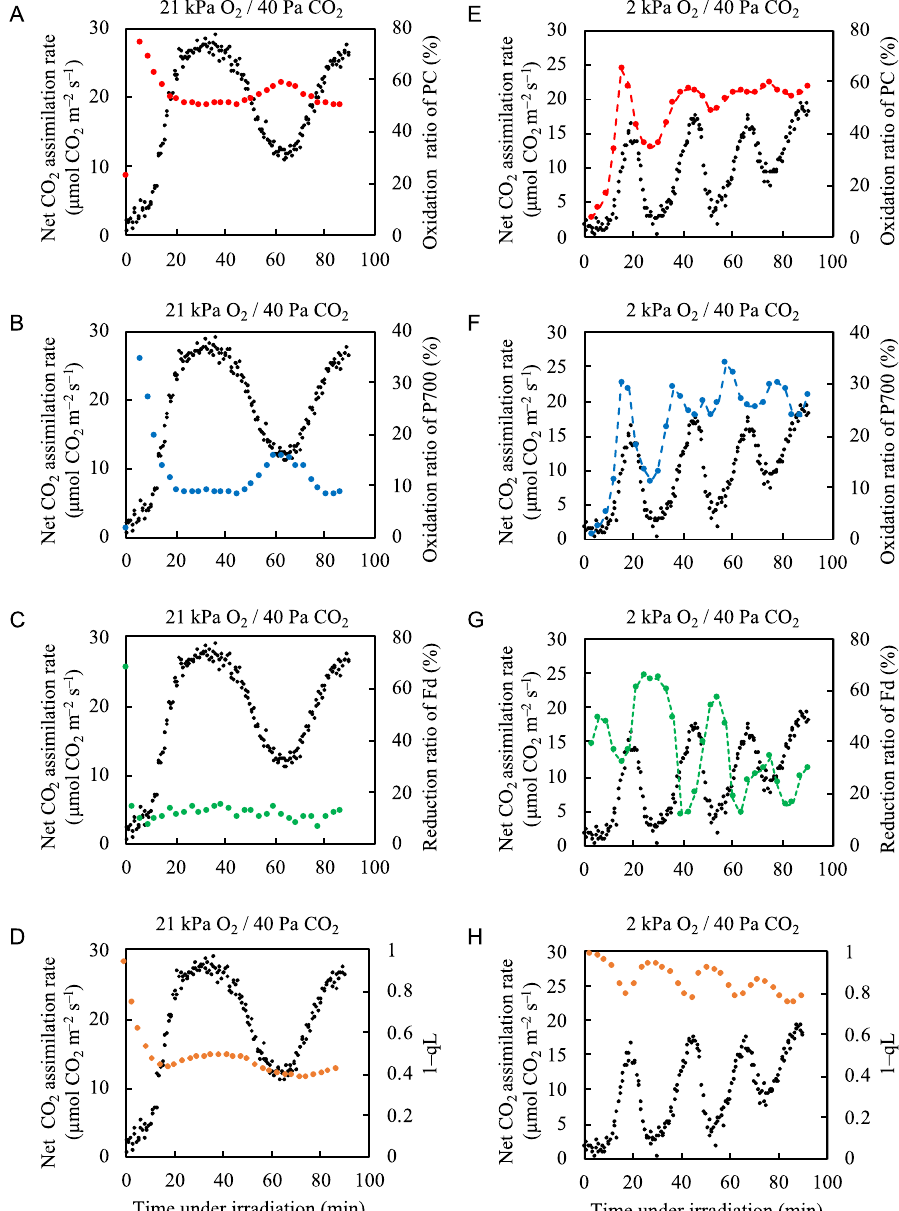
Figure 3. E ff ects of the partial pressure of O 2 on the net CO 2 assimilation rate and the redox states of plastocyanin (PC), P700, ferredoxin (Fd), and plastoquinone in rice leaves. The oxidation ratios of PC (red circles) and P700 (blue circles), and the reduction ratios of Fd (green circles) and plastoquinone (1-qL) (orange circles) were measured simultaneously with the net CO 2 assimilation rate (black circles) under 21 kPa O 2 / 40 Pa CO 2 conditions ( A–D ) and 2 kPa O 2 / 40 Pa CO 2 conditions (E-H). Actinic light (700 µ mol photons m –2 s –1 ) was turned on at 0 min. The data for the net CO 2 assimilation rate at 21 kPa O 2 are the same as used for Fig. 1A and the data for the net CO 2 assimilation rate at 2 kPa O 2 are the same as those used for Figure 2B. Dashed lines in the graph ( E–G ) was arbitrarily drawn to indicate the trend of the